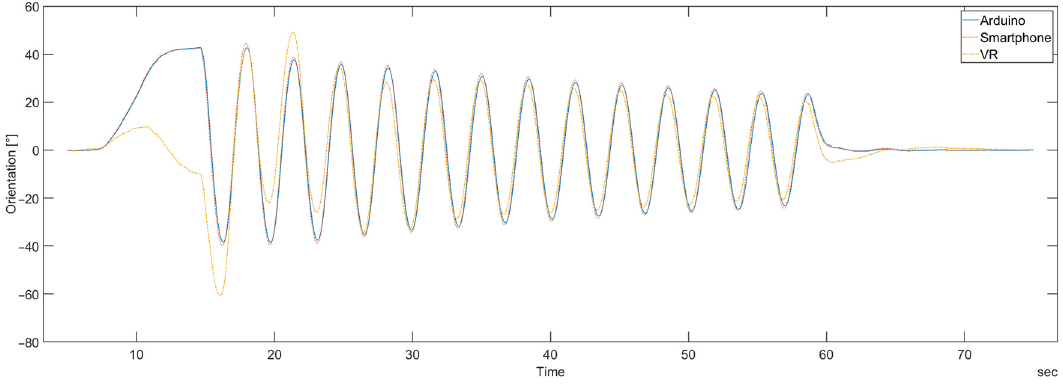
Figure 18. The orientation on the z-axis of different types of devices, calculated for the entire duration of a measurement.